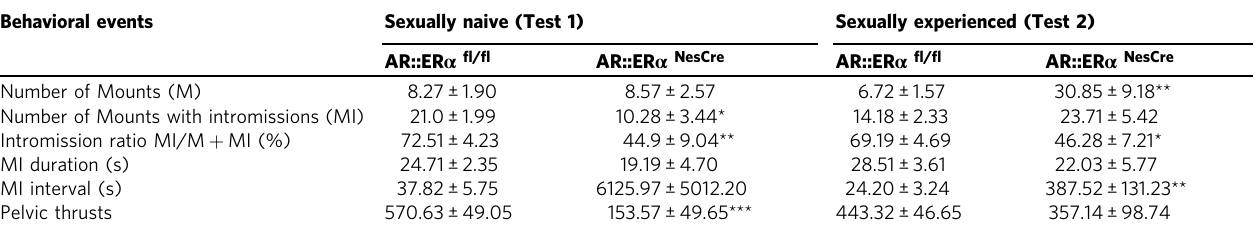
Table 3 Sexual behavior of AR::ER α NesCre males. Behavioral events